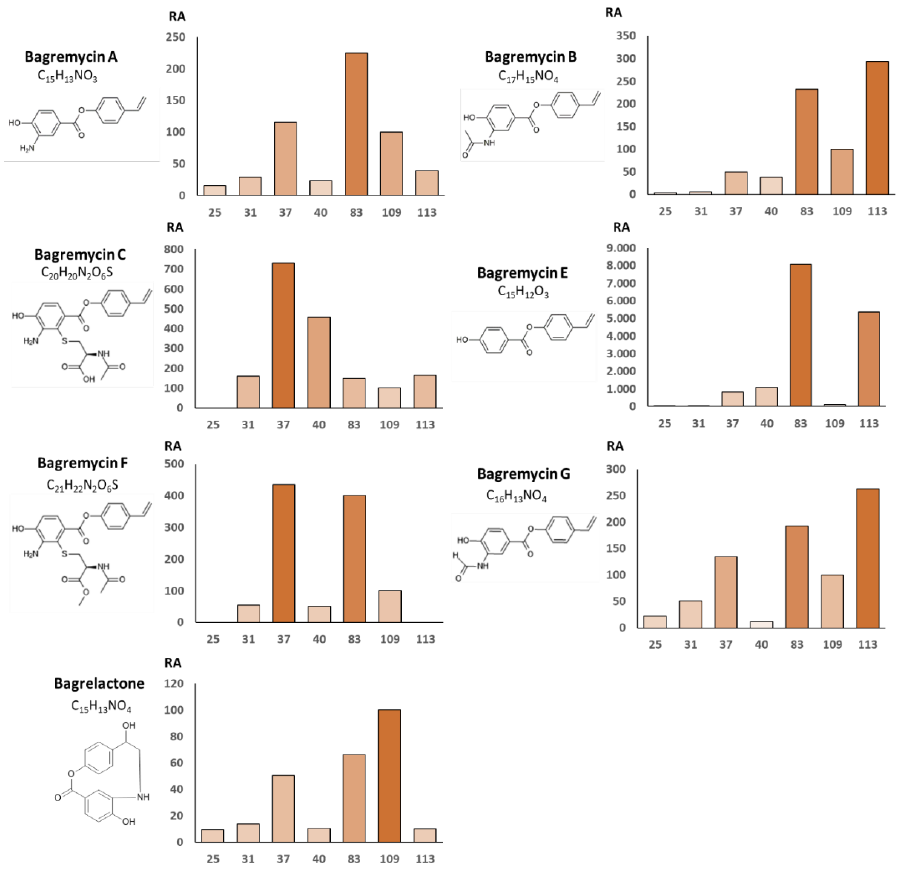
Figure 5. Production levels of bagremycins by seven S. lunaelactis strains. The relative abundance (RA) of bagremycins in the full extracts of S. lunaelactis strains was performed by peak integration of the extracted ion chromatogram (EIC) using the level produced by S. lunaelactis MM109 T (fixed to 100%) as reference.